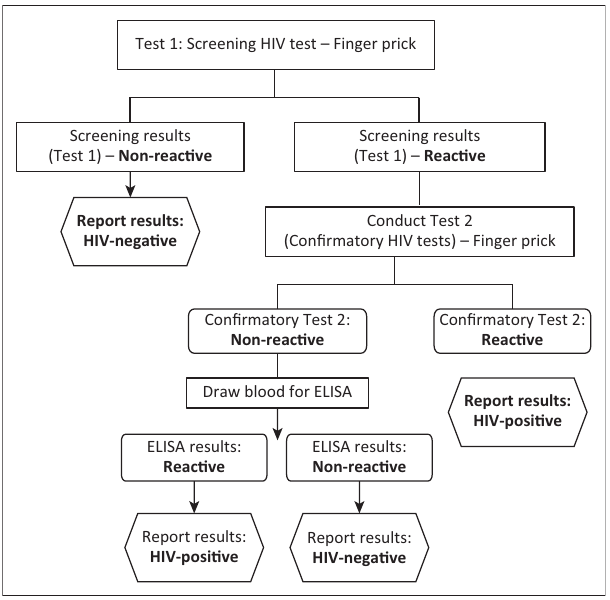
FIGURE 1: Recommended HIV testing algorithm for antenatal HIV testing in South